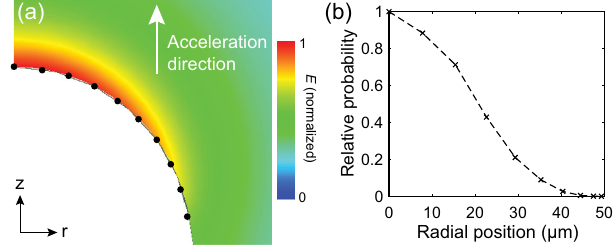
FIG. 3. (a) HFSS electric field on the tip showing the points which were used to discretize the emission area. (b) Relative probability of emission at those points based on the current density calculated from the Fowler-Nordheim equation.